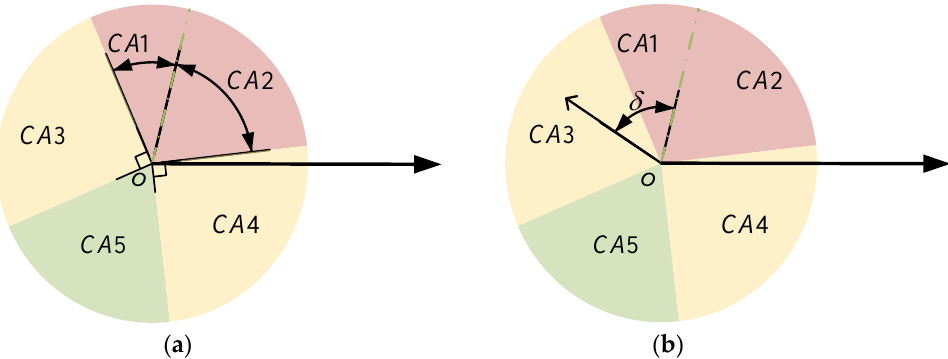
Figure 6. Velocity obstacle cone and extended velocity obstacle cone. ( a ) Velocity obstacle cone and expanded velocity obstacle cone. ( b ) The angle between the relative velocity direction and the connecting line between the center points of the two ships.